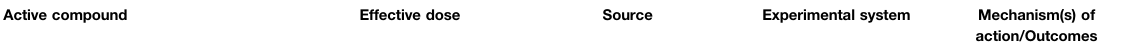
TABLE 1 | ( Continued ) Synthesized fi ndings for potential bioactive compounds for